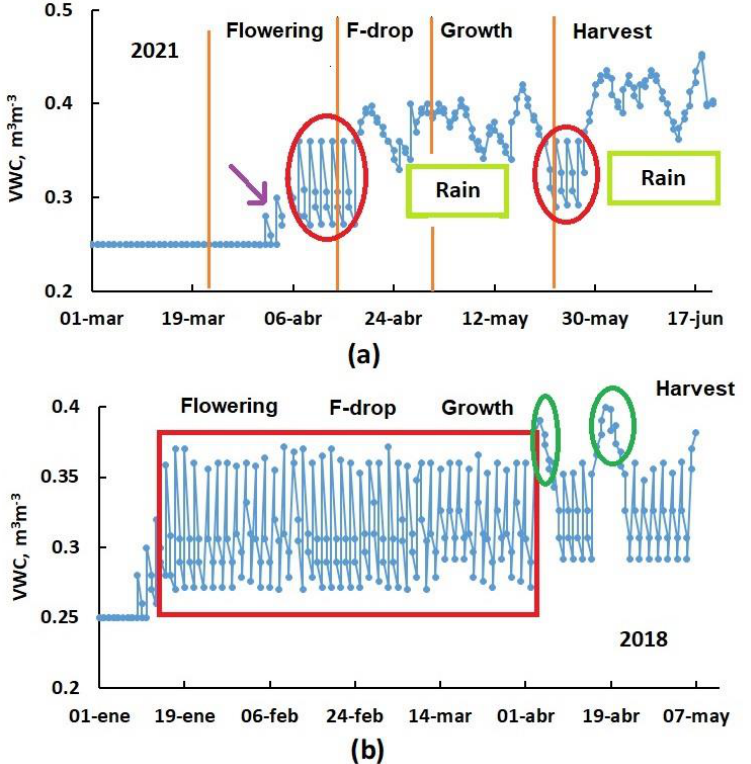
Figure 19. Daily soil moisture monitoring during ( a ) 2021 and, ( b ) 2018 after irrigation application and rainfall. Weeds grow fast with surface rainwater allowing seeds to germinate, Table 1. Weeds interfere with micro-sprinklers reducing their wetting area, Figure 20. Without weeds, sprinklers wet an area with a diameter of 3 m. The humid soil area was reduced by half